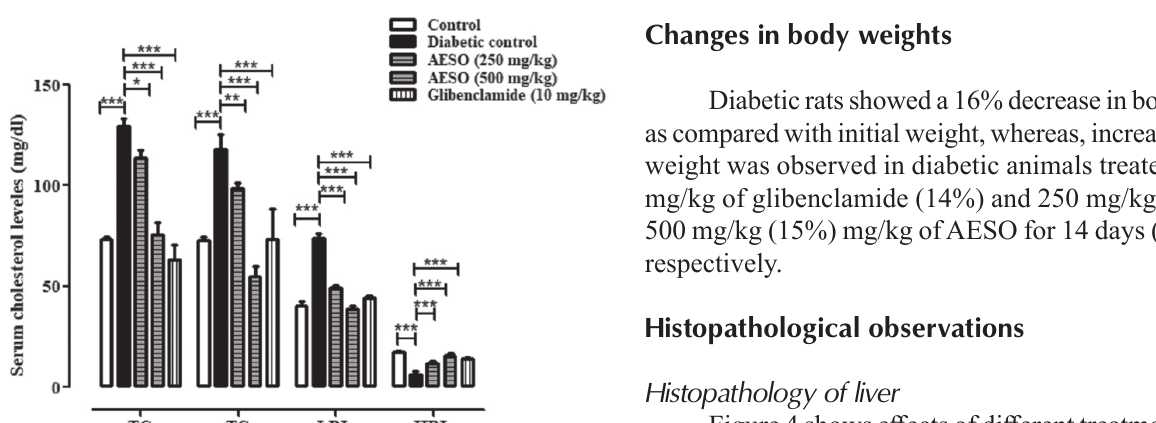
Values are expressed as mean ± SEM. Comparison was made between lipids levels in serum samples of alloxan-induced diabetic rats and AESO and glibenclamide treated animals Where TC = Total cholesterol, TG = Triglycerides, LDL = Low density lipoproteins,